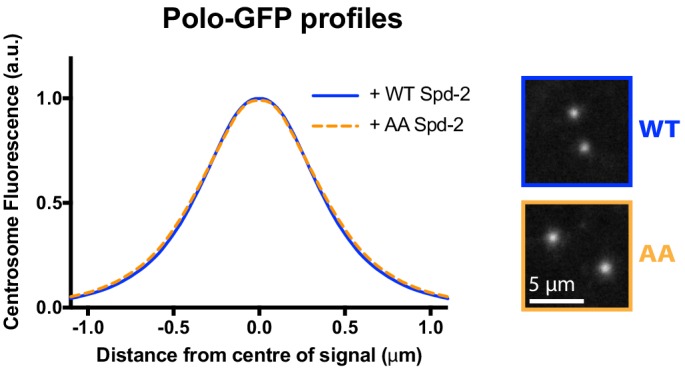
Spd-2-AA-mKate2 does not detectably perturb the centrosomal distribution of Polo-GFP.Graph compares the radial distribution of Polo-GFP around the mother centriole in living WT embryos expressing Polo-GFP and injected with mRNAs encoding either WT Spd-2-mKate2 or Spd-2-AA-mKate2, as indicated; five centrosomes per embryo were analysed: n = 5 and 6 embryos, respectively.Insets show examples of typical spinning disk-confocal images used for this analysis. Note that these datasets are not normalised to each other, and the AA mutation does not detectably perturb the localisation of Polo-GFP.10.7554/eLife.50130.047Figure 9—figure supplement 2—source data 1.Radial profile analysis.